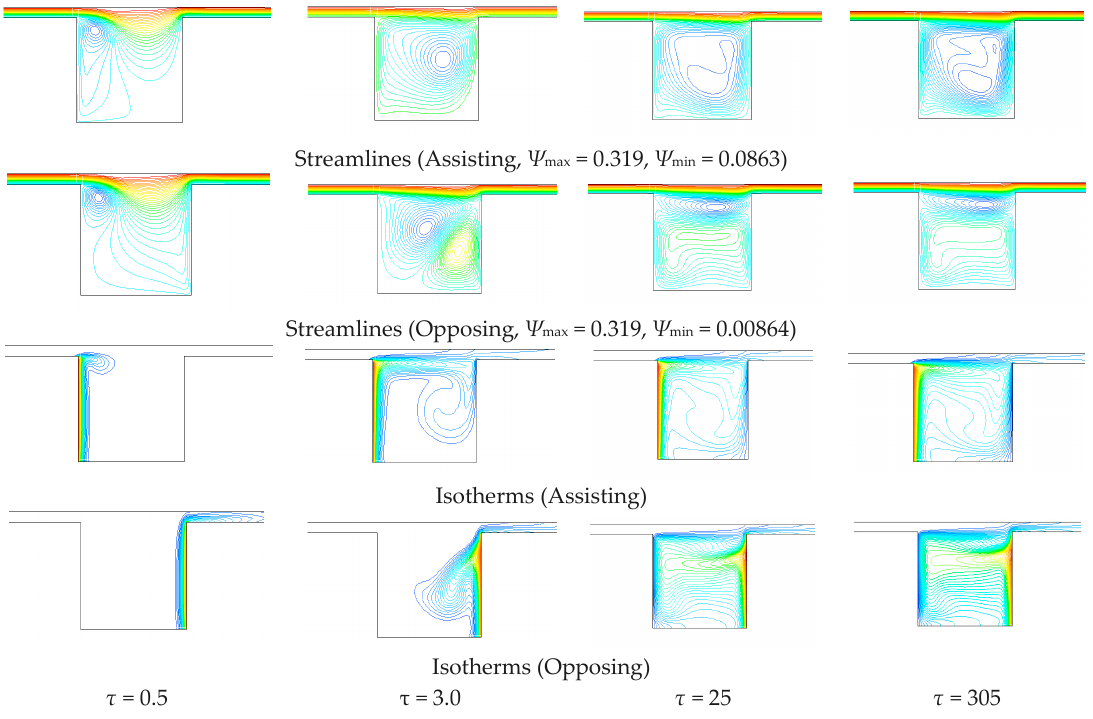
Figure 5. Streamlines and isotherms for Re = 100, aspect ratio (AR) = 1.0 and Ri = 123.00.